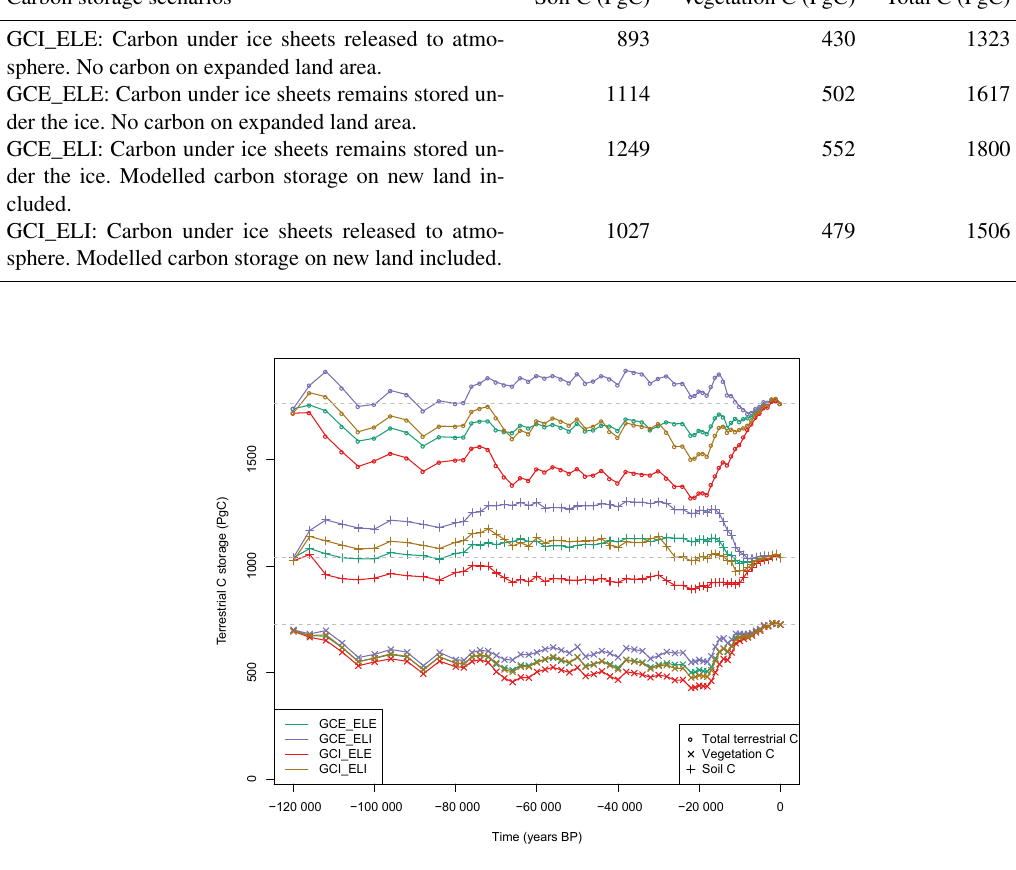
Figure A1. Absolute changes in carbon stores (vegetation and soil) over time. The four scenarios are as detailed in Table